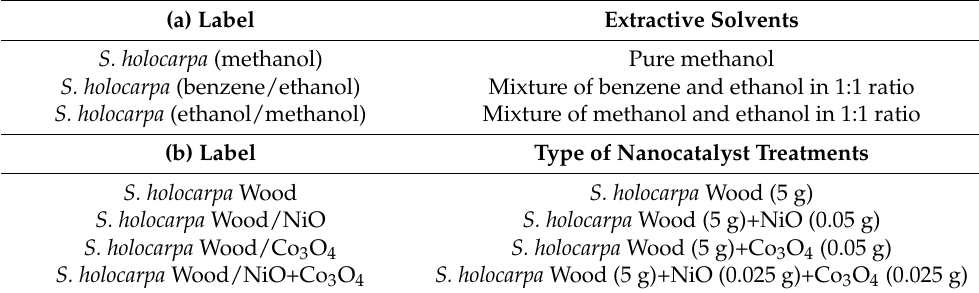
Table 1. Types of nanocatalyst treatments and extractive solvents. (a)